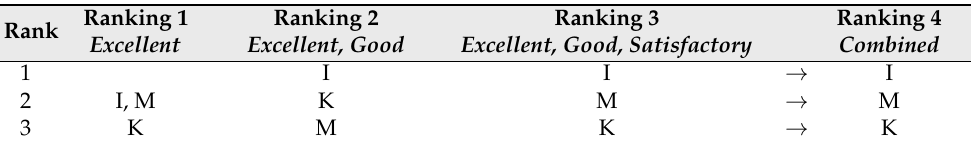
Figure 7. Class- and best-ranking of Kit-I, -K and -M. Given are ( A ) the class-ranking with the pro- portions of cases with sufficient (excellent, good, satisfactory) and insufficient DC/DC leu -generation using kits and ( B ) the best-ranking with proportions of cases with best- and second-best DC/DC leu - generation using kits. Table 4. Class-ranking of selected kits.